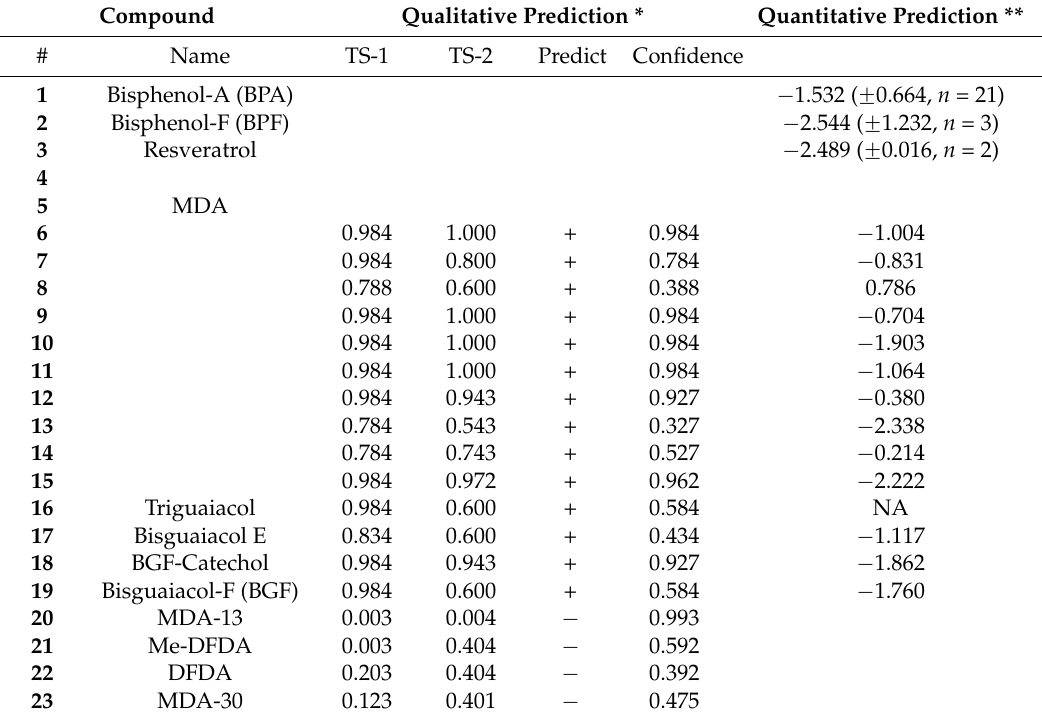
Table 1. Estrogenic activity predictions of potential BPA replacement compounds. Compound Qualitative Prediction